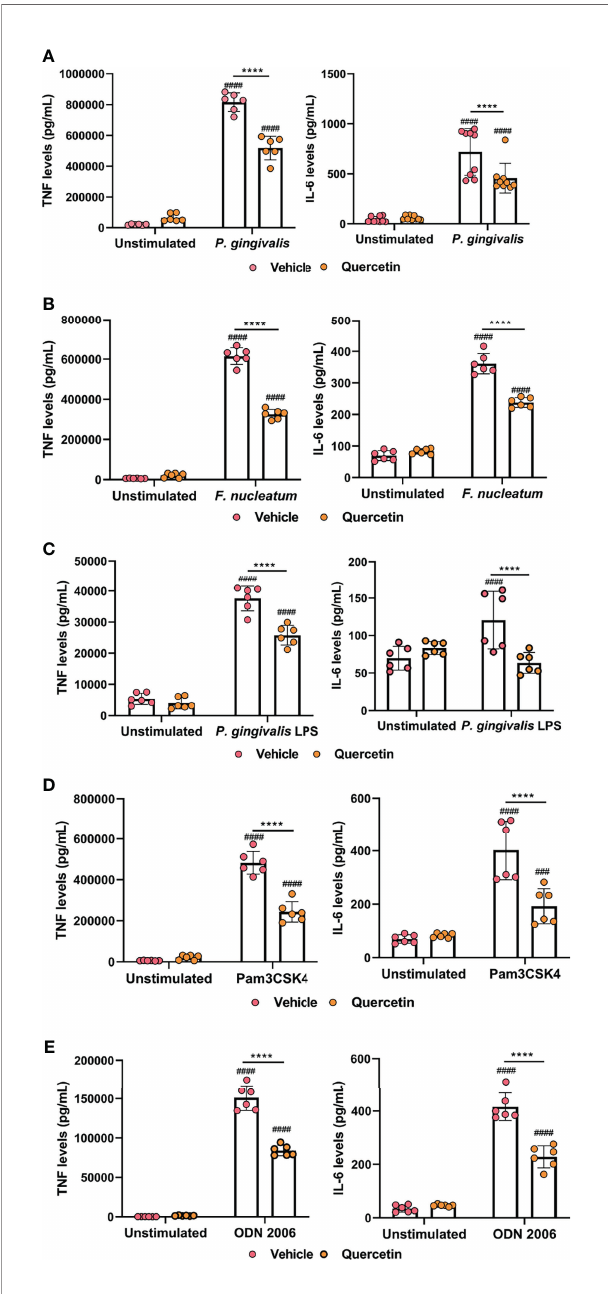
FIGURE 4 | Quercetin diminishes cytokine production in human macrophages challenged with oral bacteria and toll-like receptor agonists. THP-1 macrophages treated with Quercetin (5µg/mL) or vehicle matched control were infected with oral bacteria or toll-like receptor agonists for up to 24 hours. (A – E) IL-6 and TNF levels in the supernatants were determined with ELISA. ELISA was conducted on (A) macrophages infected with P. gingivalis (100 MOI), (B) macrophages infected with F . nucleatum (50 MOI), (C) macrophages infected with P. gingivalis LPS (10µg/mL), (D) macrophages infected with Pam3CSK4 (10ng/mL) and (E) macrophages infected with ODN 2006 (100µg/mL). Each experiment was performed at minimum three times independently and averages and standard deviations are shown. ****p ≤ 0.0001. #### Unstimulated control cells versus corresponding stimulated cells (p ≤ 0.0001). ### Unstimulated control cells versus corresponding stimulated cells (p ≤